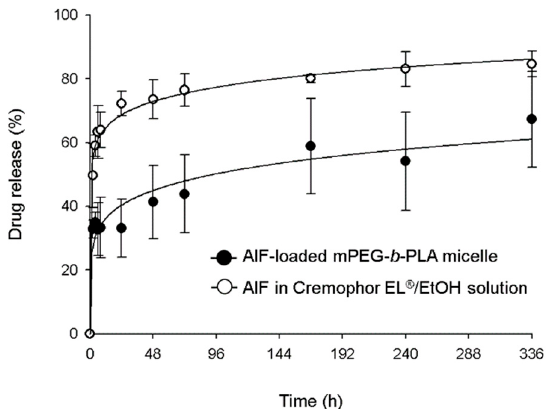
Figure 5. In vitro release profile of alpinumisoflavone (AIF) from mPEG- b -PLA micelles and Cremophor EL ® /EtOH solution at 37 °C.